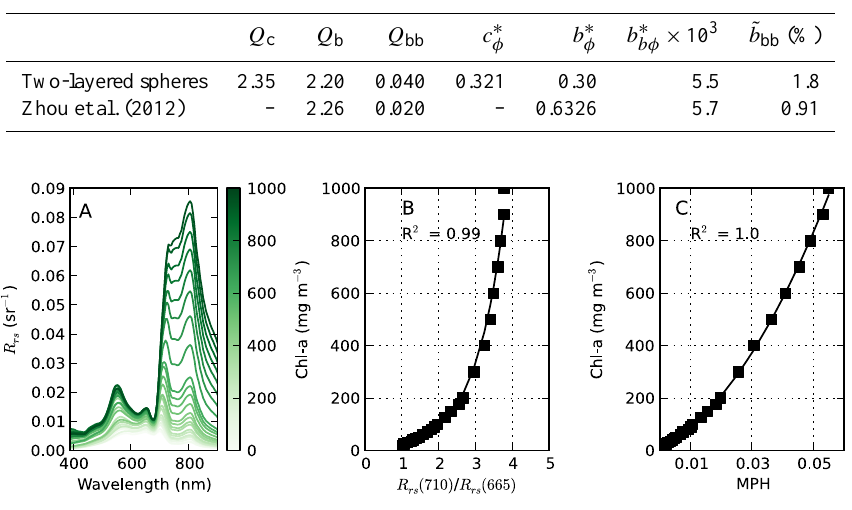
Fig. 10. (A) R rs simulated for Chl a between 20 and 1000mgm − 3 for a vacuolate M. aeruginosa population with random perturbations in tripton concentration and a g (440). Empirical relationships between Chl a and the 710:665 band ratio (B) and between Chl a and the maximum peak height (MPH) variable (C) showing the best fit